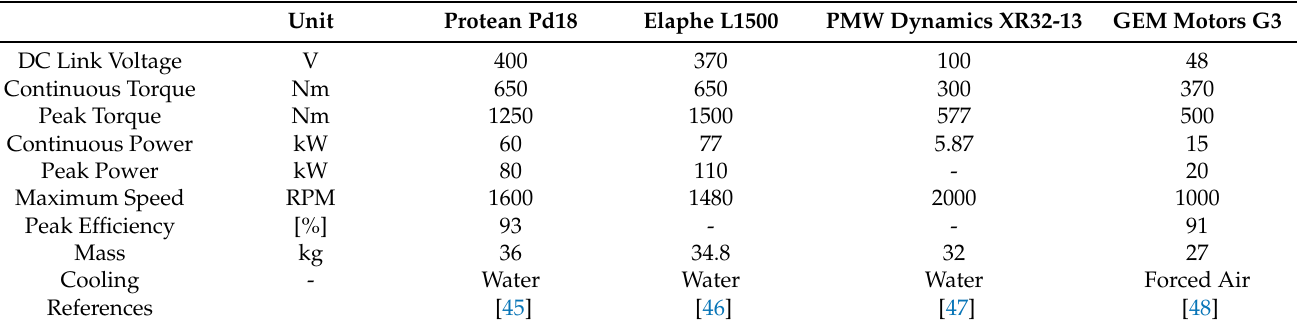
Table 2. Comparison of commercial radial flux IWM with